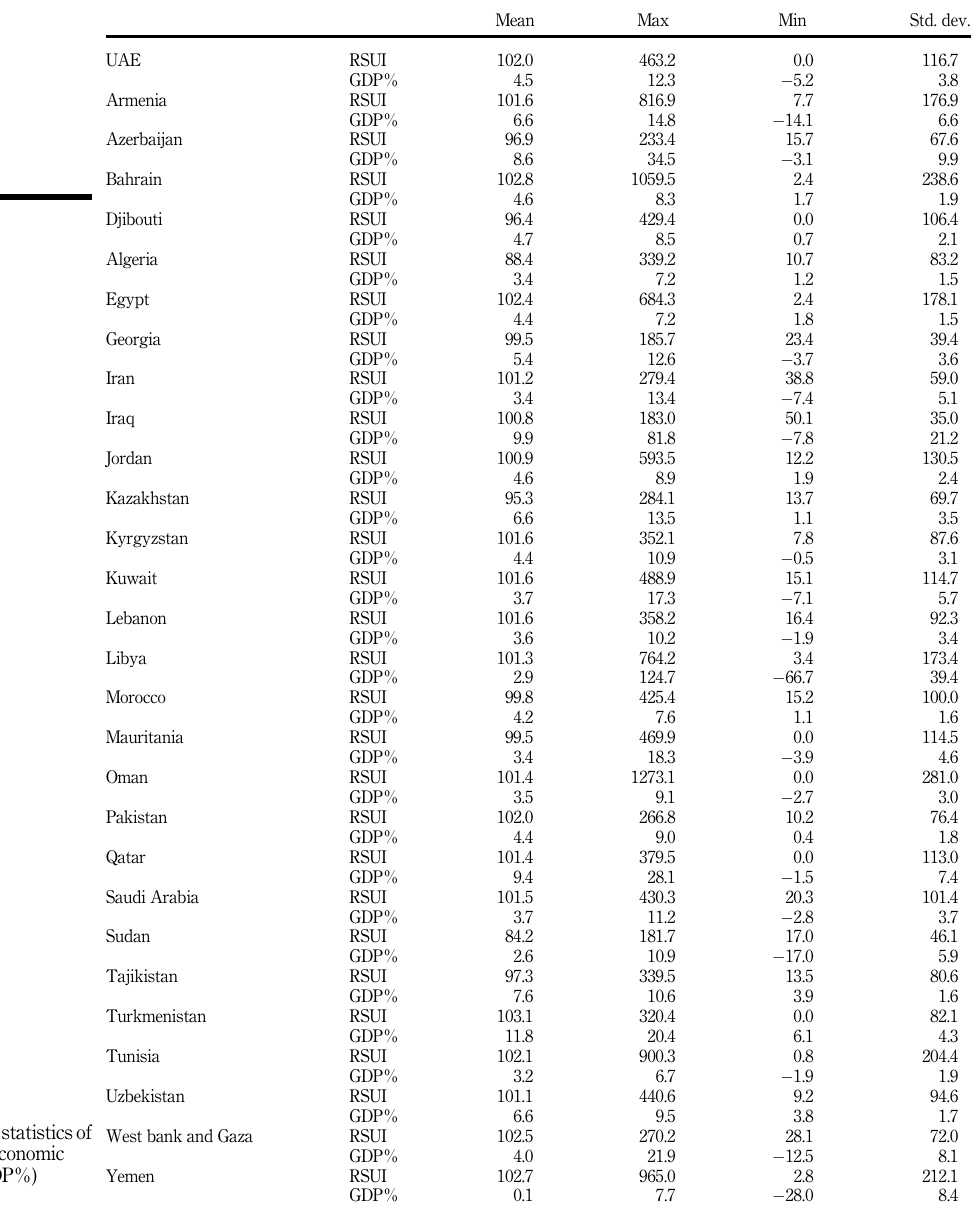
Table 1. Descriptivestatisticsof RSUI and economic growth